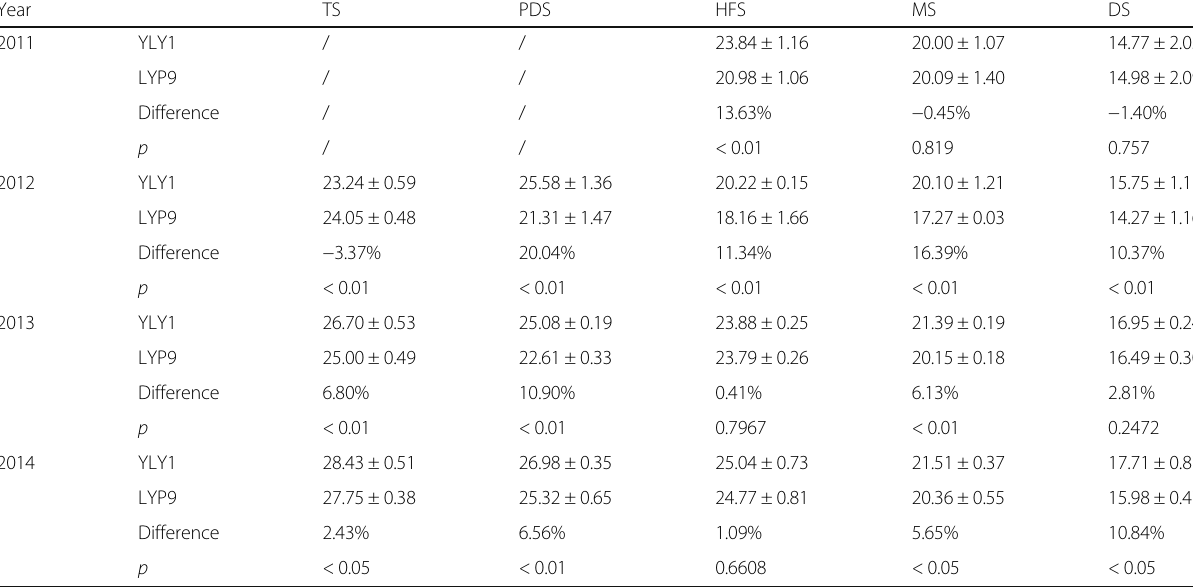
Table 2 The net photosynthesis rate (P n ) of uppermost or flag leaves with a portable photosynthesis system LI-6400XT,